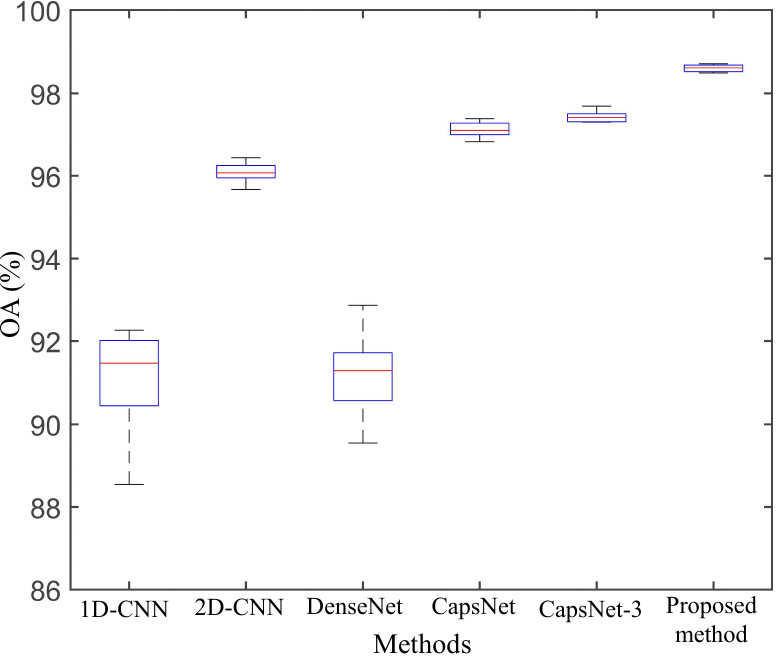
Figure 17. Box plot of the five repeated experimental results on GF-3